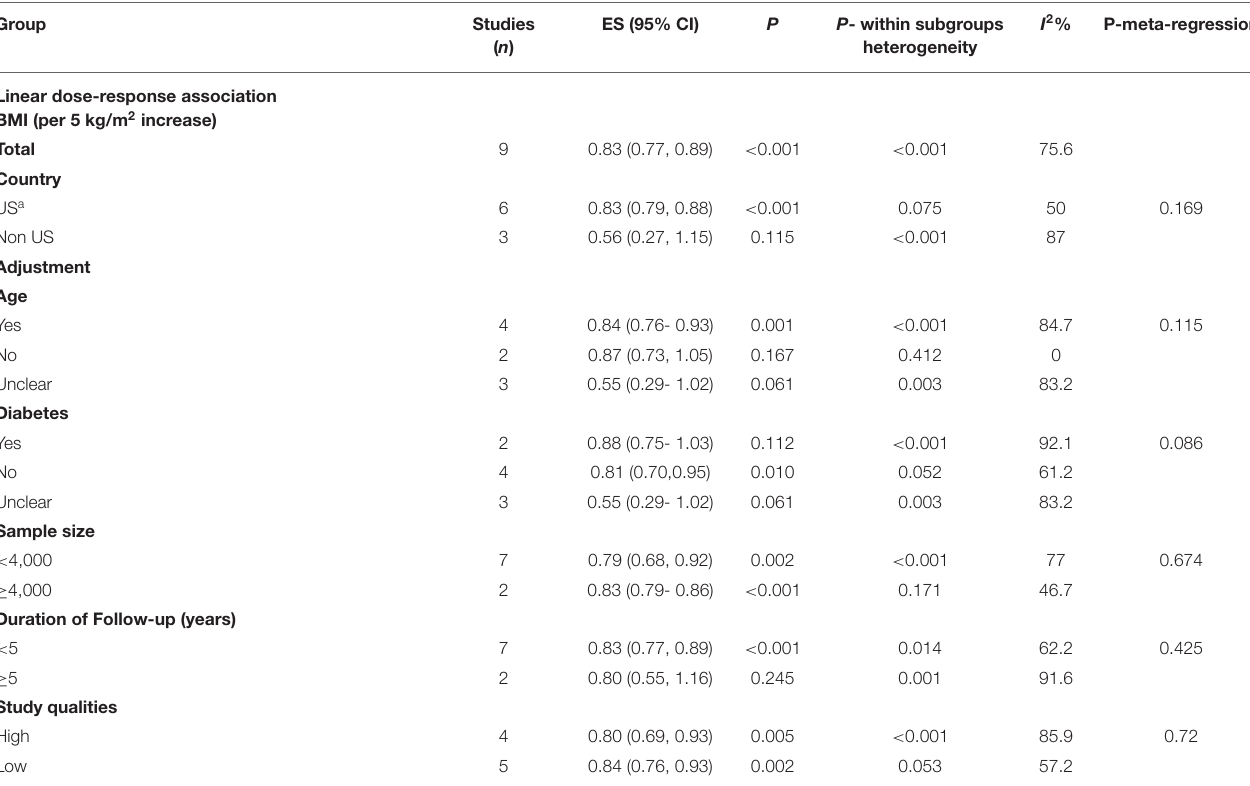
TABLE 3 | Results of subgroup analysis for body mass index and risk of mortality among pulmonary hypertension patients. Group Studies